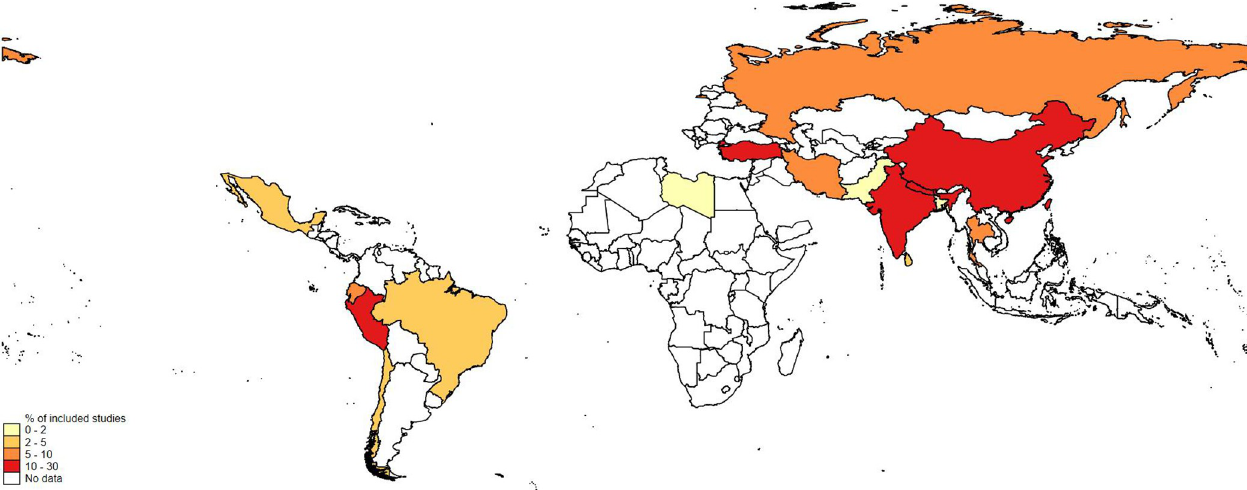
Fig 2. Distribution of evidence from low- and middle-income countries on the impact of COVID-19 on suicidal behaviour. The base map layer used to construct the map was obtained from Esri (https://hub.arcgis.com/datasets/esri::world-countries-generalized/about). High income countries are not represented in the map.